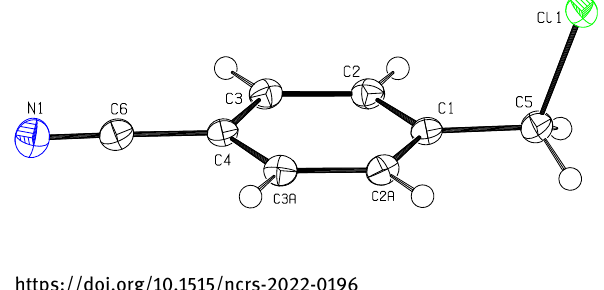
Table  : Data collection and handling.